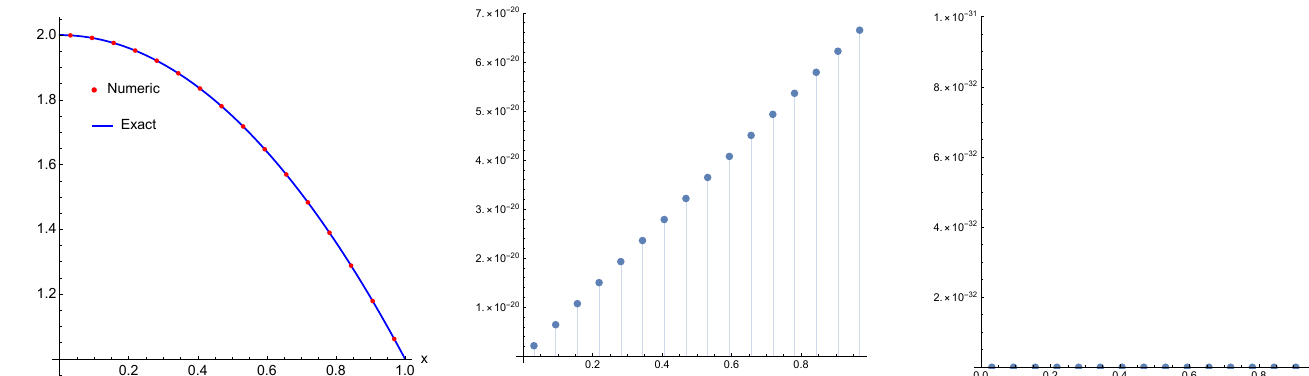
Figure 10. The numerical solution (points) with exact solution ( left ) and the absolute error computed for Example 7 with machine precision ( middle ), and with double precision ( right